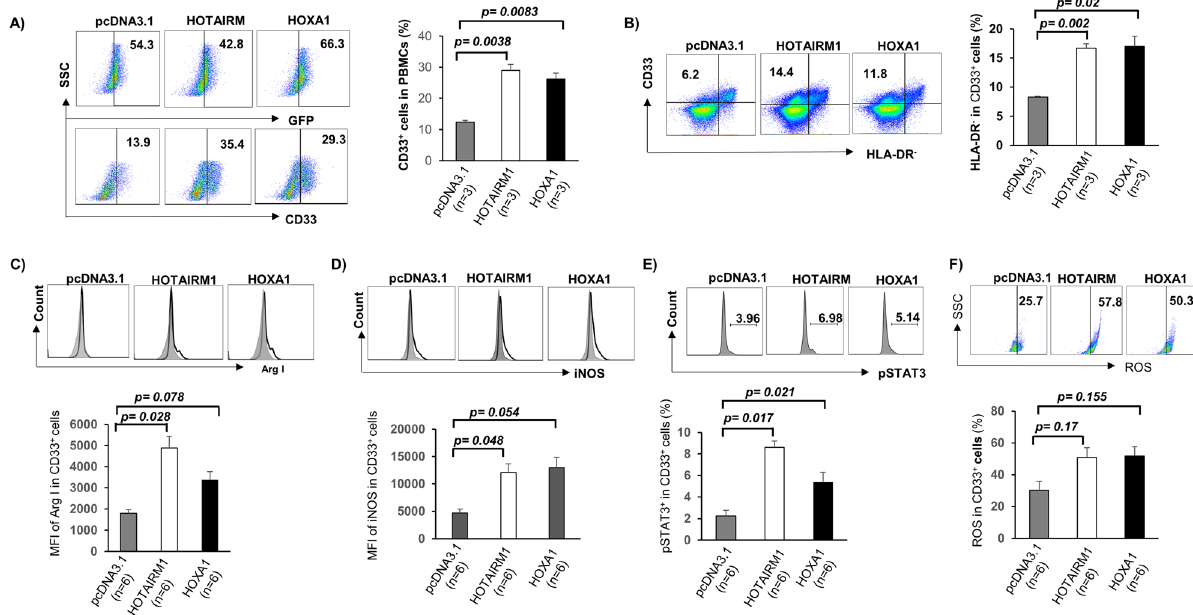
Figure 5. Ectopic overexpression of HOTAIRM1 or HOXA1 in healthy CD33 + cells affects MDSC differentiation and immunosuppressive functions. ( A ) Transfection of HOTAIRM1 or HOXA1 plasmid into PBMCs isolated from HS promotes CD33 + cell differentiation. ( B ) Ectopic expression of HOTAIRM1 or HOXA1 promotes CD33 + cell differentiation into MDSCs (determined by higher levels of HLA-DR − cells). ( C–F ) Overexpression of HOTAIRM1 or HOXA1 in healthy CD33 + cells enhances Arg1, iNOS, pSTAT3, and ROS productions, as determined by flow